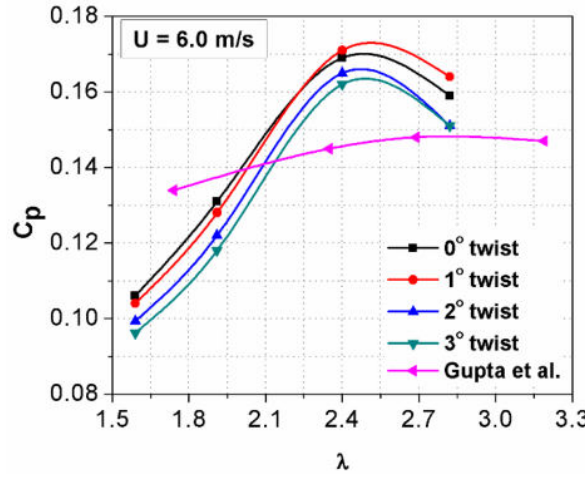
Figure 8. Variations of C p with TSR for different degree of blade twist turbine and also compared with existing results